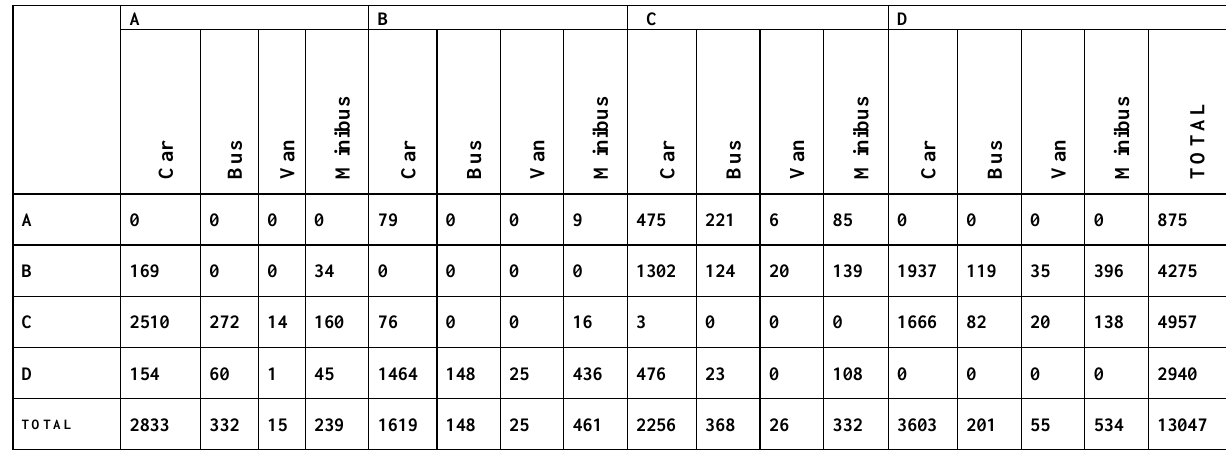
Table 2. Traffic volume counts in the morning of K1 junction (07: 00-09: 00)